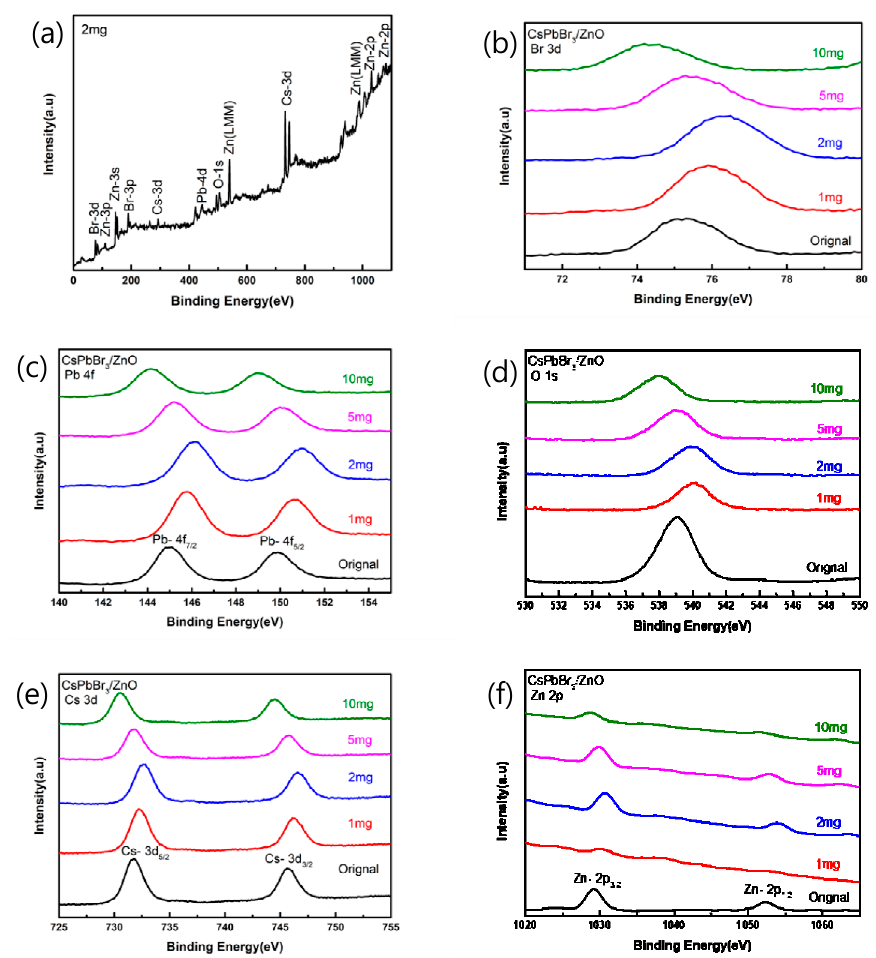
Figure 5. XPS spectra of pa-ZnO-doped CsPbBr 3 films ( a ) added 2 mg of pa-ZnO nanopowder, and ( b – f ) in different binding energy range.